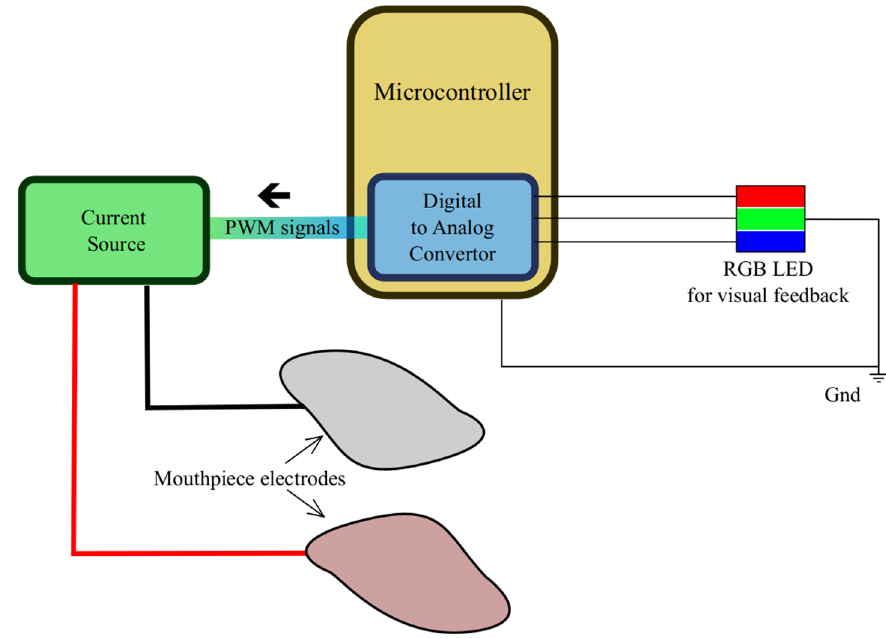
Figure 3. The general block diagram of the taste+ system.